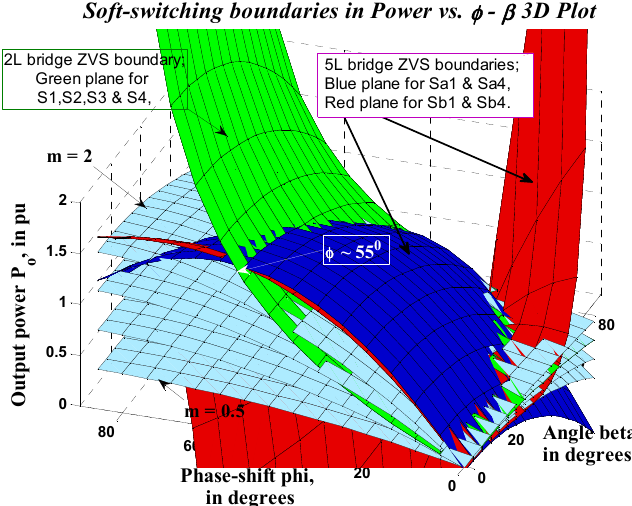
Figure 10. Soft switching boundaries shown in three-dimensional power vs. (cid:2038) - (cid:2010) planes (where (cid:2009) = 15 (cid:2868) , 0 < (cid:2010) < 90 (cid:2868) and 0 < (cid:2038) < 90 (cid:2868) ) ; the grey planes (15) show the power vs. phi-beta relations for m = 0.5, 1, 1.5, 2; the green plane (17) is for two-level bridge, and the zero voltage switching (ZVS) is possible while operating under this plane; the blue (18) and red (19) planes are for five-level bridge leg- a and leg- b ,